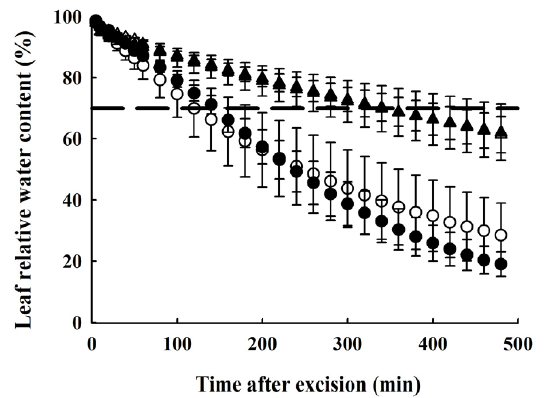
Figure 6. Leaf dehydration curves of C. helferiana (triangles) and C. rex (circles) grown under 100% (open symbols) and 50% (filled symbols) sunlight conditions, showing changes of relative water content (RWC) with time after excision. The horizontal dashed line shows RWC of 70%. Values are means ± 1SE ( n = 4). Note, the curves of C. helferiana in the two light conditions overlapped.